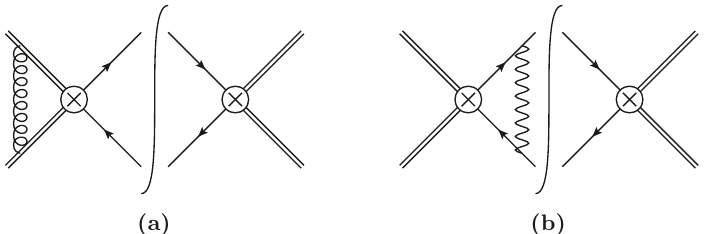
Figure 1 . Relevant Feynman diagrams for the virtual part of the TMDShF. Double solid lines stand for soft Wilson lines, while single lines for heavy quarks. The gluon in diagram 1a is soft, while the one in diagram 1b, denoted with a wavy line, is ultrasoft. Corresponding crossed diagrams should be